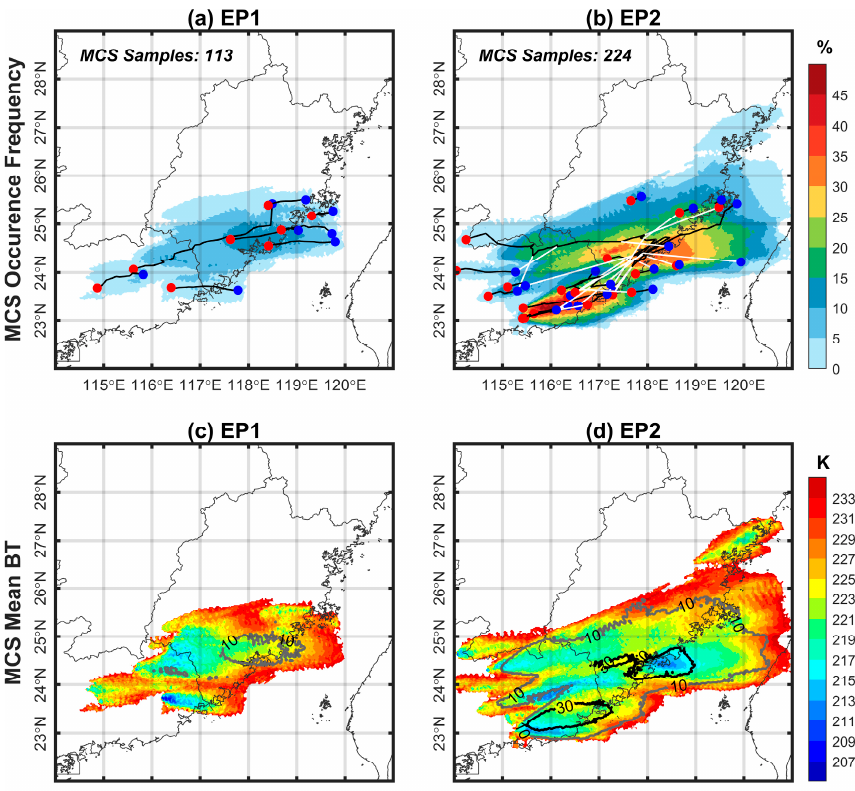
Figure 8. Spatial distributions of ( a , b ) the occurrence frequency of the identified MCS samples and ( c , d ) the averaged brightness temperature (BT) along the MCS pathway in two successive warm- sector rainfall episodes over southeastern China ( a , c ) between 0500 and 2200 LST on 6 May 2018 (EP1) and ( b , d ) between 0000 and 1700 LST on 7 May 2018 (EP2). MCS trajectories are given by black (“continuity” status) and white (“merging” status) lines in ( a , b ), with red dots denoting the origin and blue dots denoting the terminus. The 10% and 30% occurrence frequencies of the MCS samples are contoured in gray and black in ( c , d ), respectively. The provincial boundaries are denoted by gray curves.